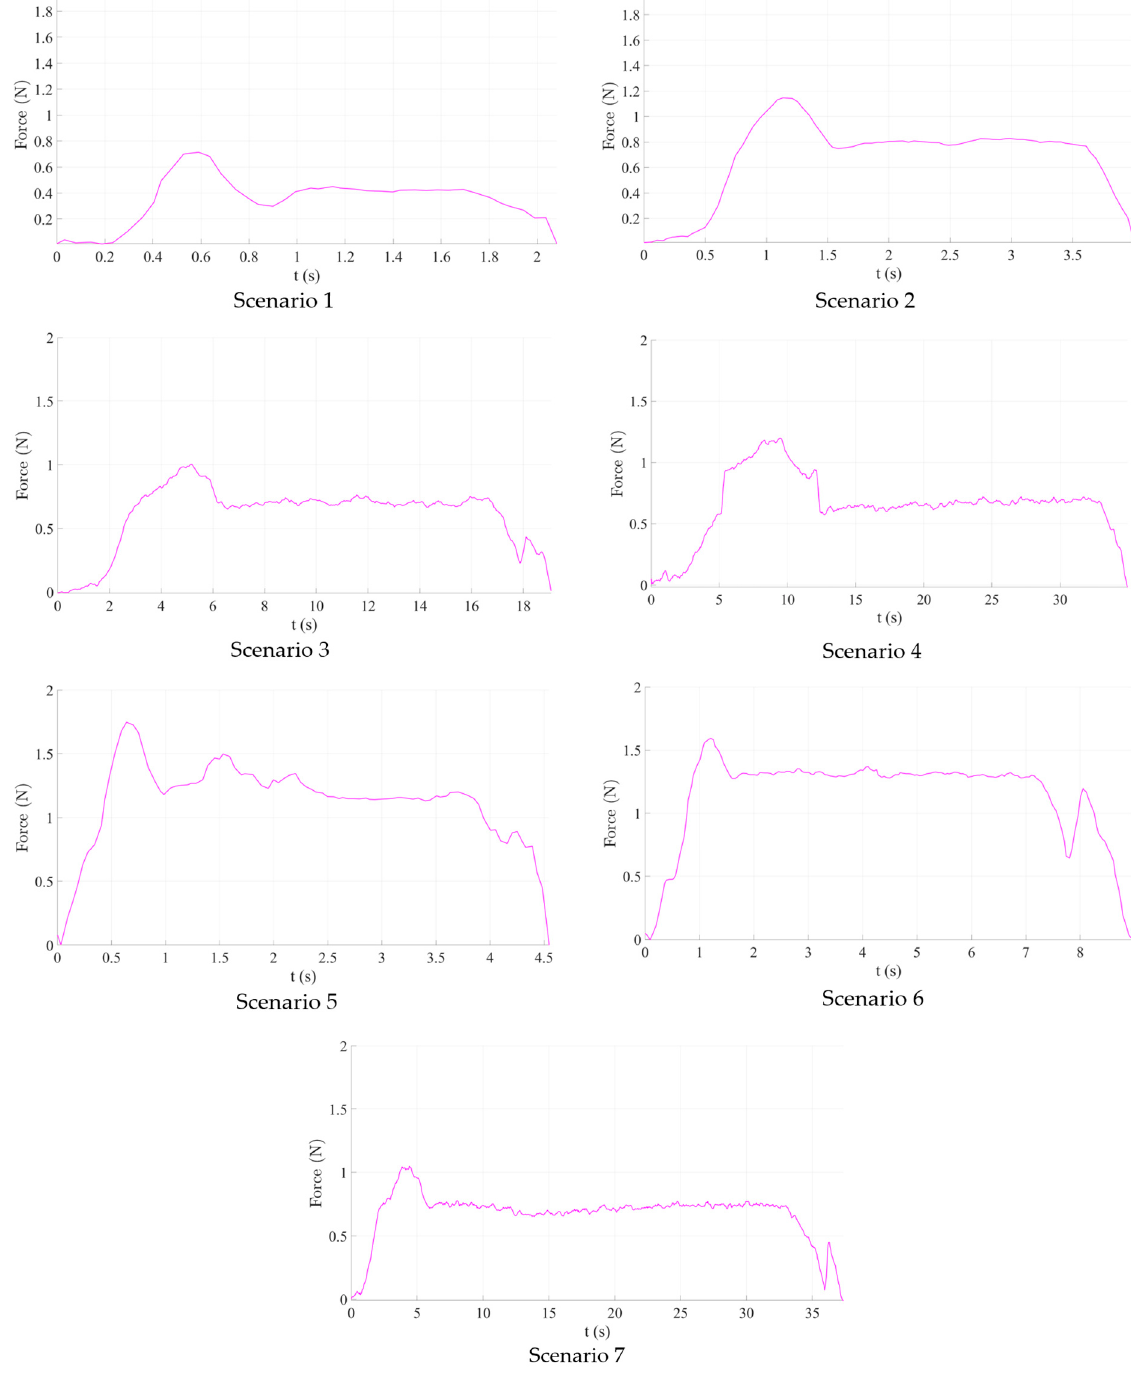
Figure 10. Graphical representation of the experimental results. Scenario no.1. The maximum registered insertion force reached was 0.715 N during tissue penetration, while the mean value was 0.412 N. Immediately after penetration, the registered insertion force decreased to approximately 0.3 N before finally stabilizing. Scenario 2 (125 mm/s insertion speed) recorded a higher insertion force (approximately 1.2 N), similar to Scenario 4 (12.5 mm/s insertion speed). Nevertheless, the mean value of the measured insertion force had increased, nearly doubling (0.6–0.8 N). As the insertion